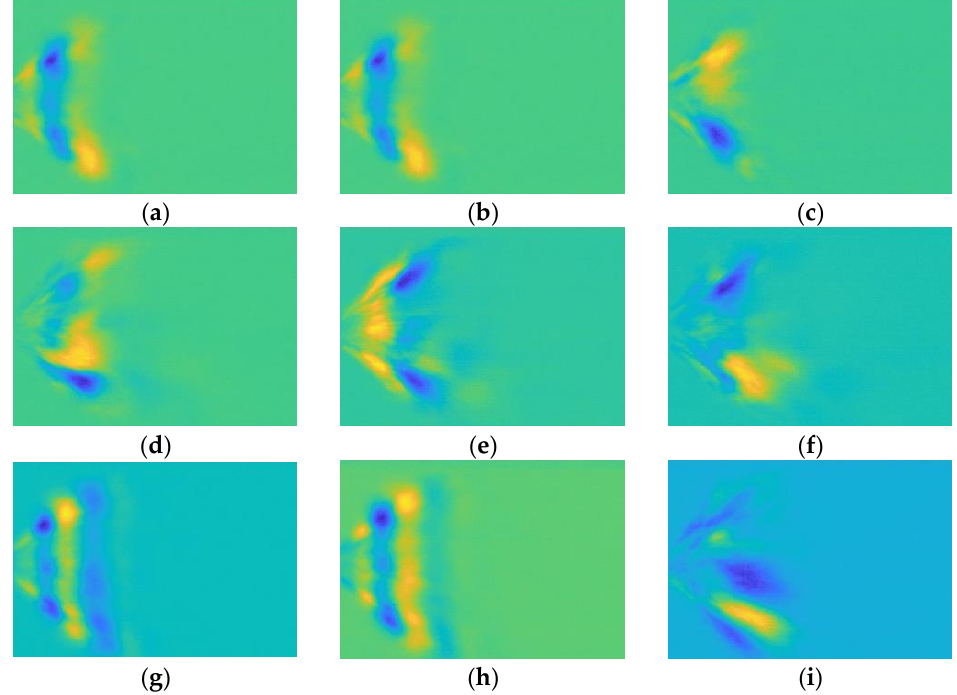
Figure 8. POD results under different swirlers. ( a – c ) The first three modes of swirler A; ( d – f ) swirler B; ( g – i ) swirler C.